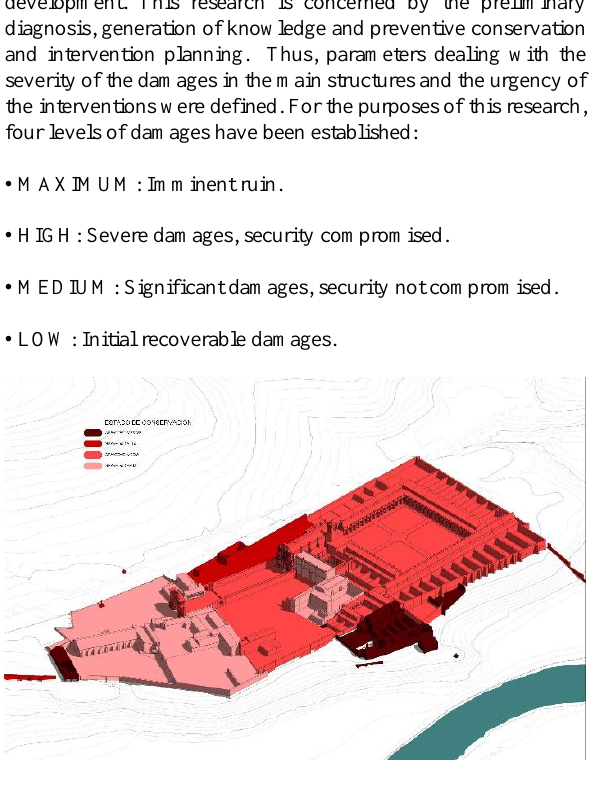
Figure 7: State of conservation: levels of damages. HBIM